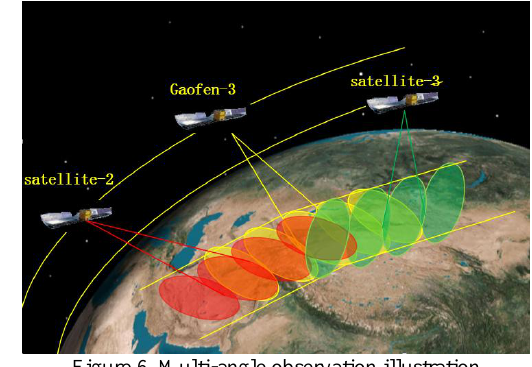
Figure 6. Multi-angle observation